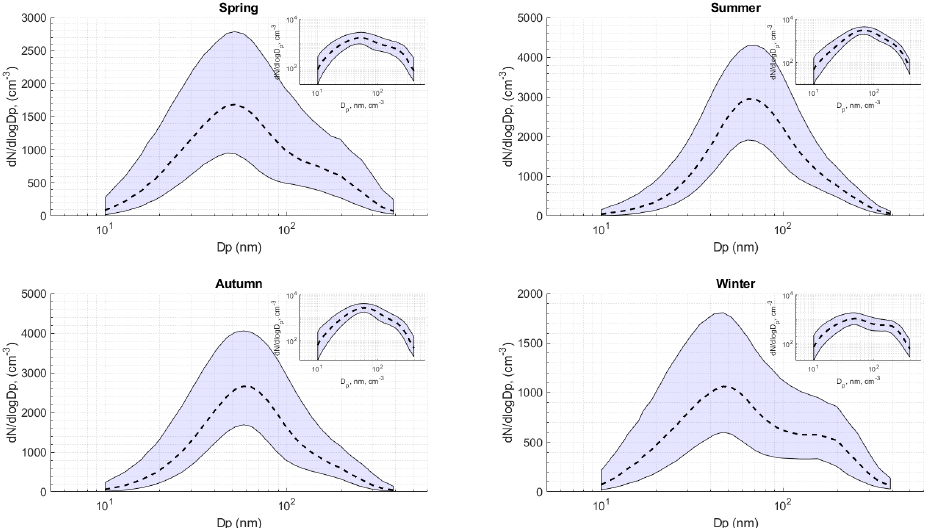
Figure 2. Seasonally average size distributions observed at Aspvreten 2000–2017. The shaded blue area gives the 25th–75th percentile range, and the dashed line shows the median size distribution. Shown in the sub-frames are the same data but now in log-log scale.